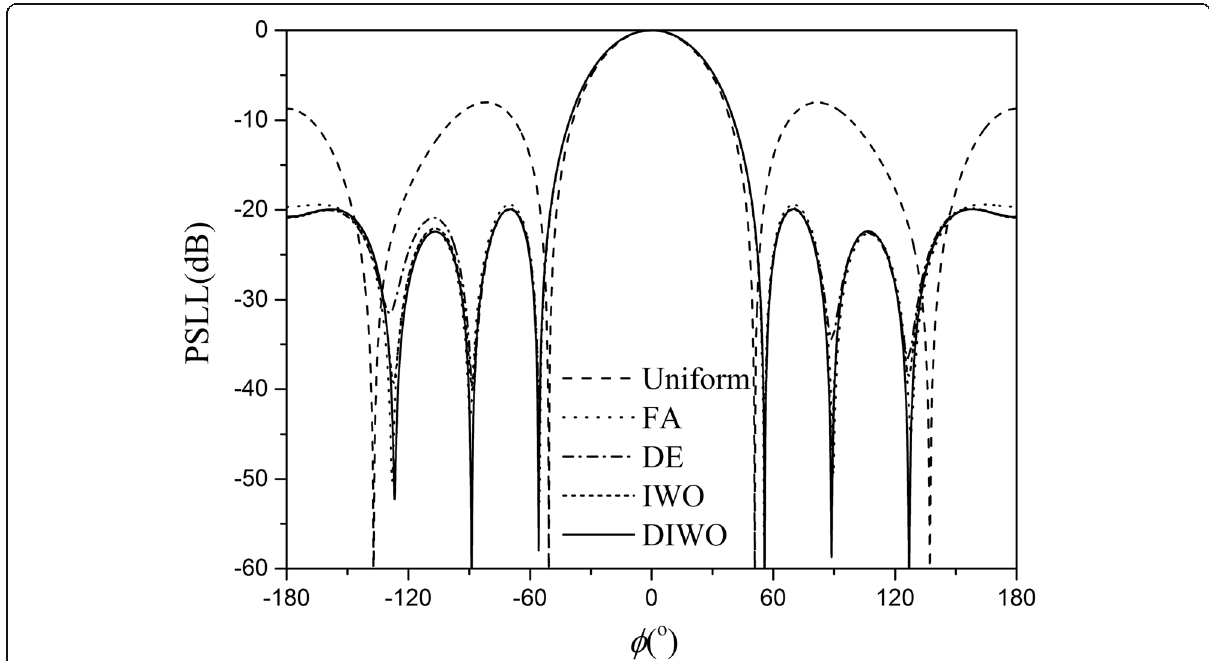
Fig. 4 Radiation pattern of elliptical antenna array with 8